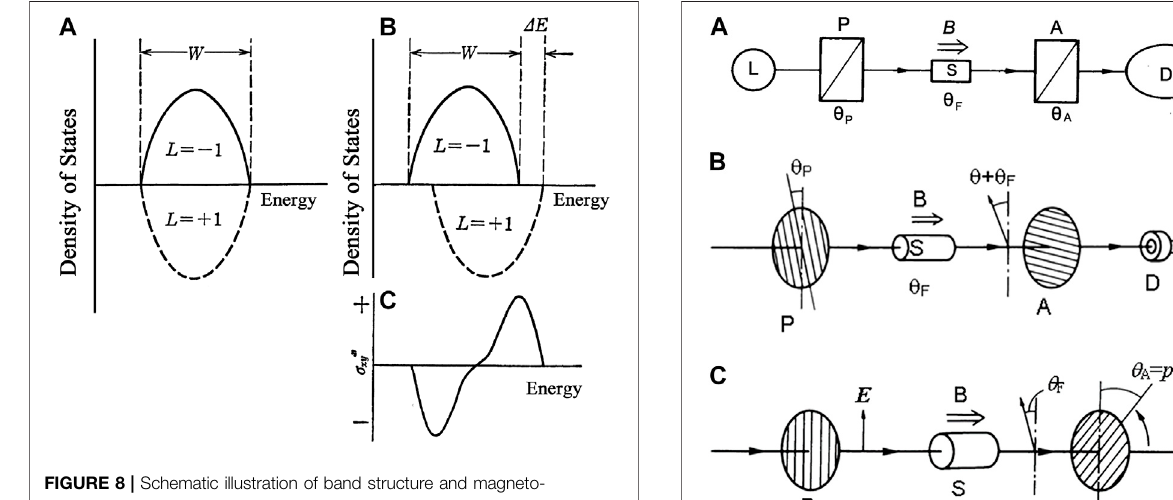
FIGURE 8 | Schematic illustration of band structure and magneto- optical spectra in metals (A) Density of state curves of a metal without magnetization (B) Density of state curves of a metal with magnetization (C) Typical magneto-optical spectrum of a metal with magnetization.